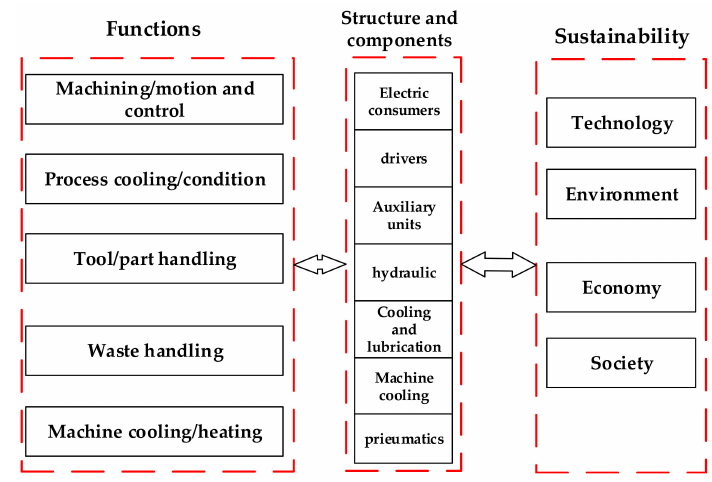
Figure 7. Machine functions to machine structure and components, and